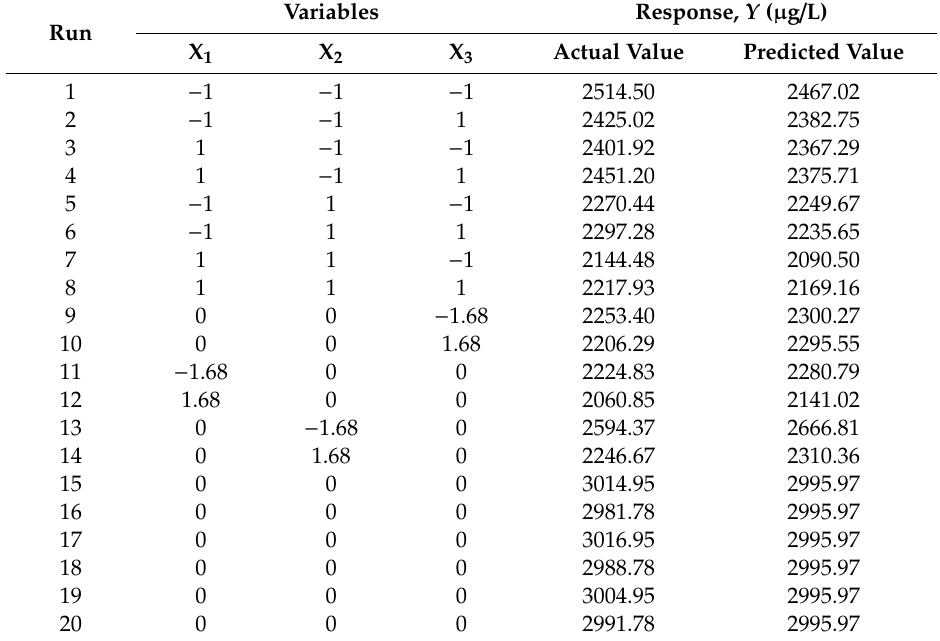
Table 4. Central composite design matrix for the e ff ect of the nutritional parameters on the astaxanthin yield in coded values and experimental